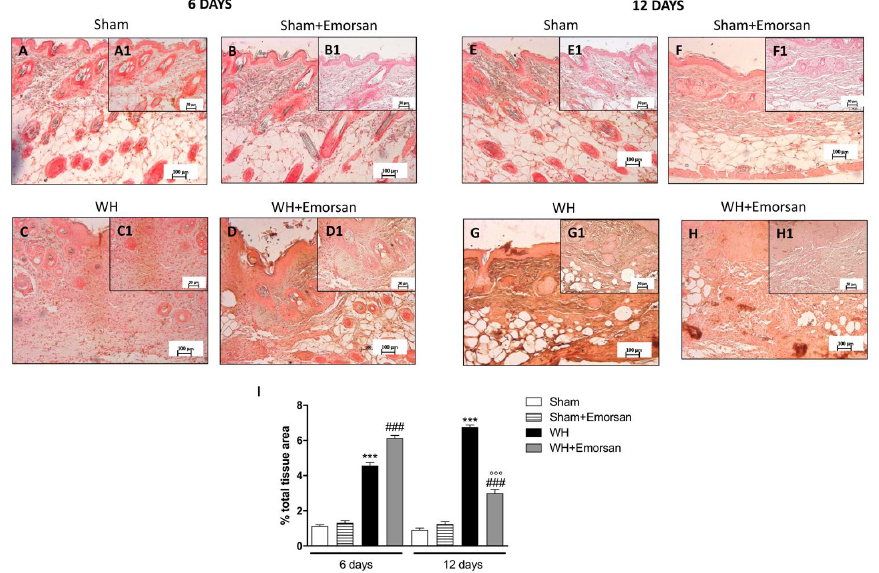
Figure 7. Effect of Emorsan ® Gel treatment on VEGF expression after WH. Mice of the vehicle group showed a marked positive immunostaining for VEGF after 6 days of WH induction ( C , C1 ,score I ) compared to sham mice both on day 6 and day 12 after WH induction ( A , A1 , B,B1,E,E1,F,F1, score I ). In the vehicle group, such positive immunostaining was even more intense 12 days after WH induction ( G , G1 ,score I ). Contrarily, Emorsan ® -treated mice revealed a modula- tion of VEGF levels, which were increased 6 days after WH induction ( D , D1 ,score I ), and decreased 12 days after the start of the experiment ( H , H1 ,score I ). Data are representative of at least three independent experiments. Values are means ± SEM. One-Way ANOVA test. *** p < 0.001 vs. corre- sponding Sham; ### p < 0.001 vs. corresponding WH; °°° p < 0.001 vs. WH+Emorsan 6 days.